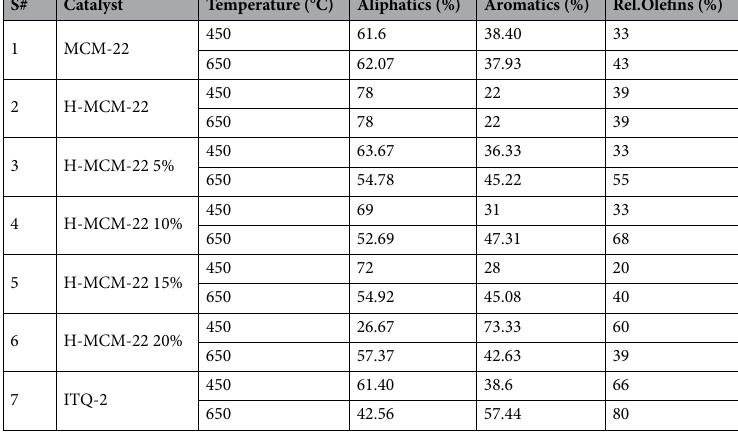
Table 2. Product distribution over synthesized catalysts for n-hexane